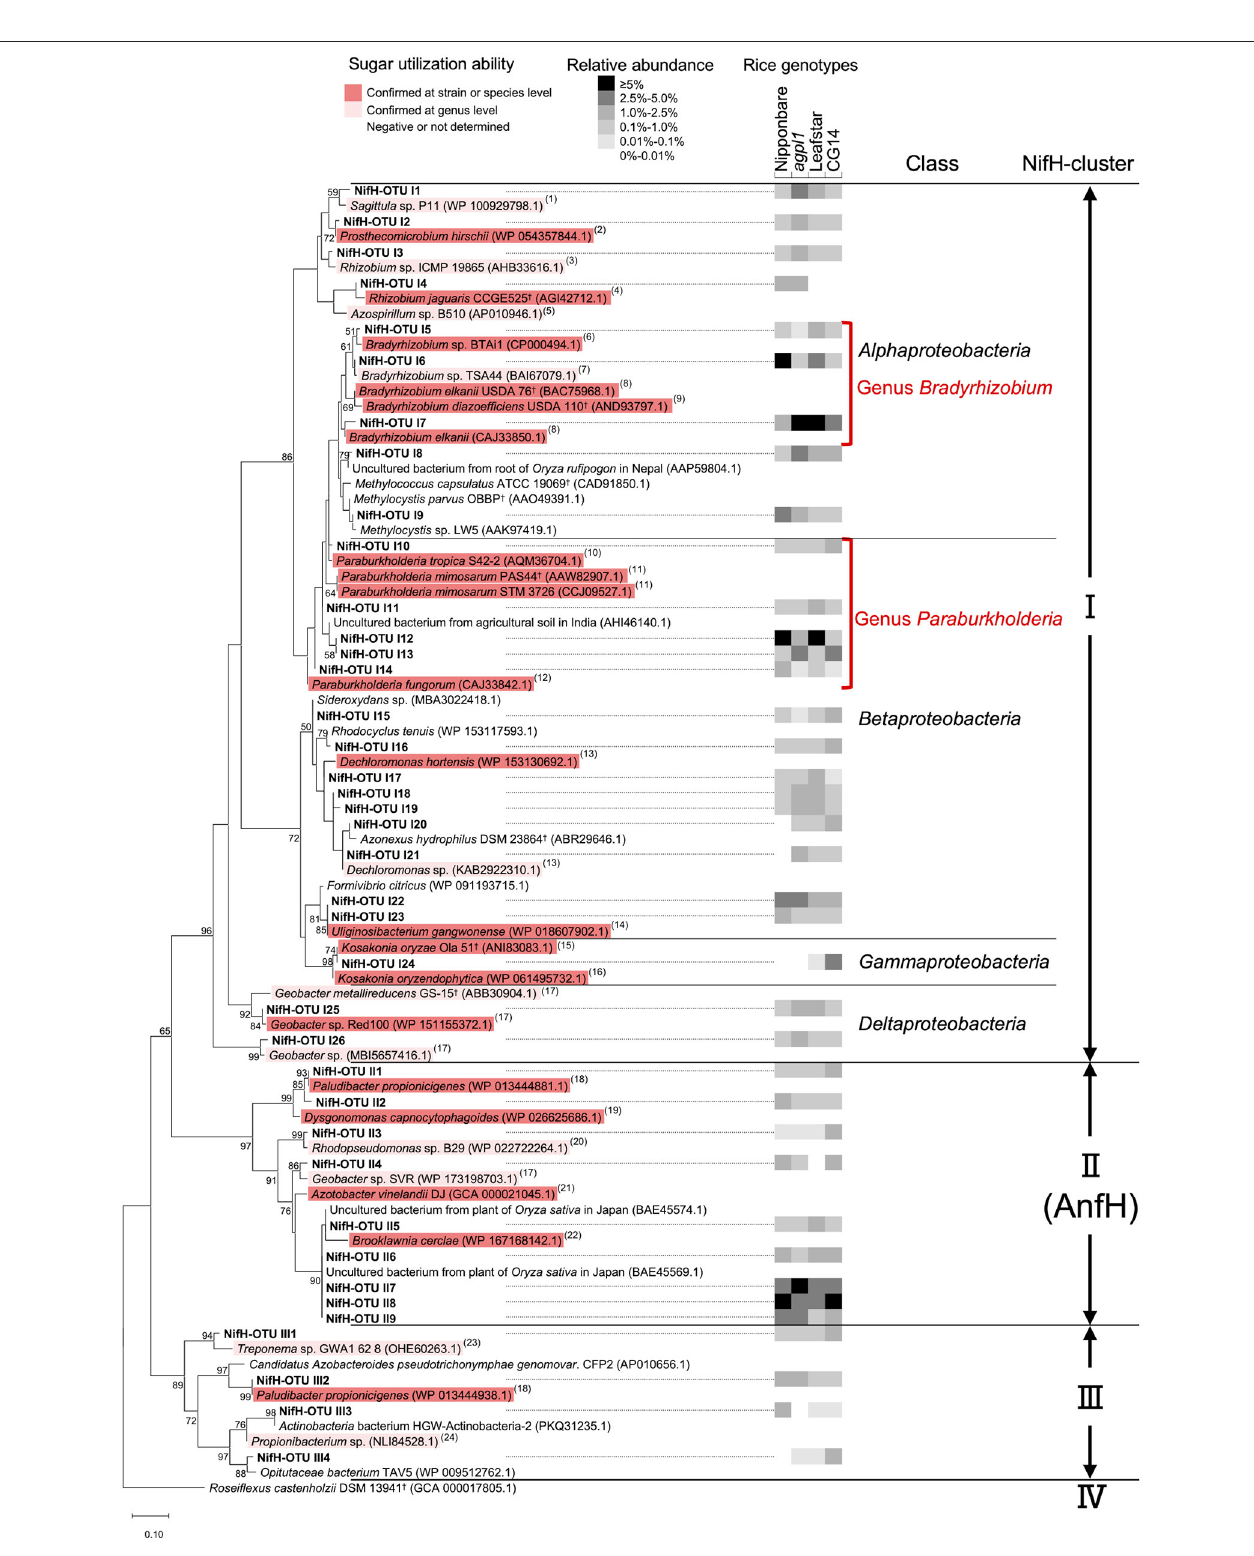
FIGURE 8 | Maximum-likelihood phylogenetic tree of NifH sequences obtained from the stems of four rice genotypes and amplified by the nifH primer set. OTUs with a mean relative abundance of ≥ 1% in at least one rice genotype were used. Bootstrap values of ≥ 50% are indicated at their respective nodes. Reference type